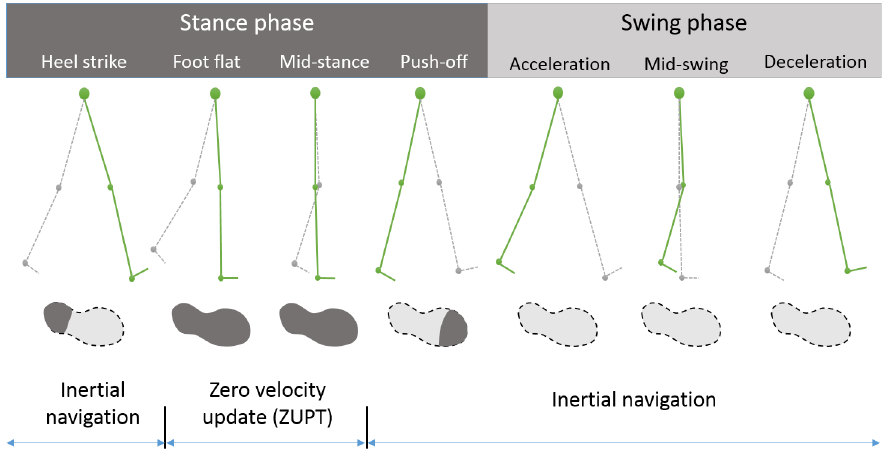
Figure 1. Walking gait cycle and measurement update